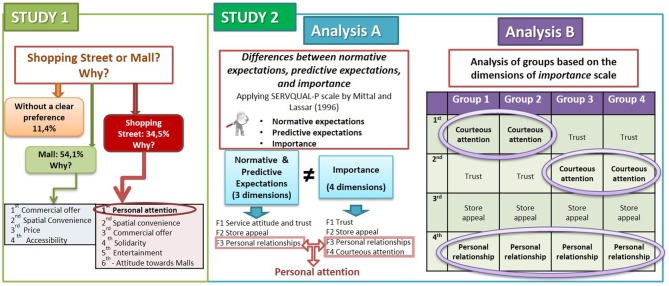
Research diagram.